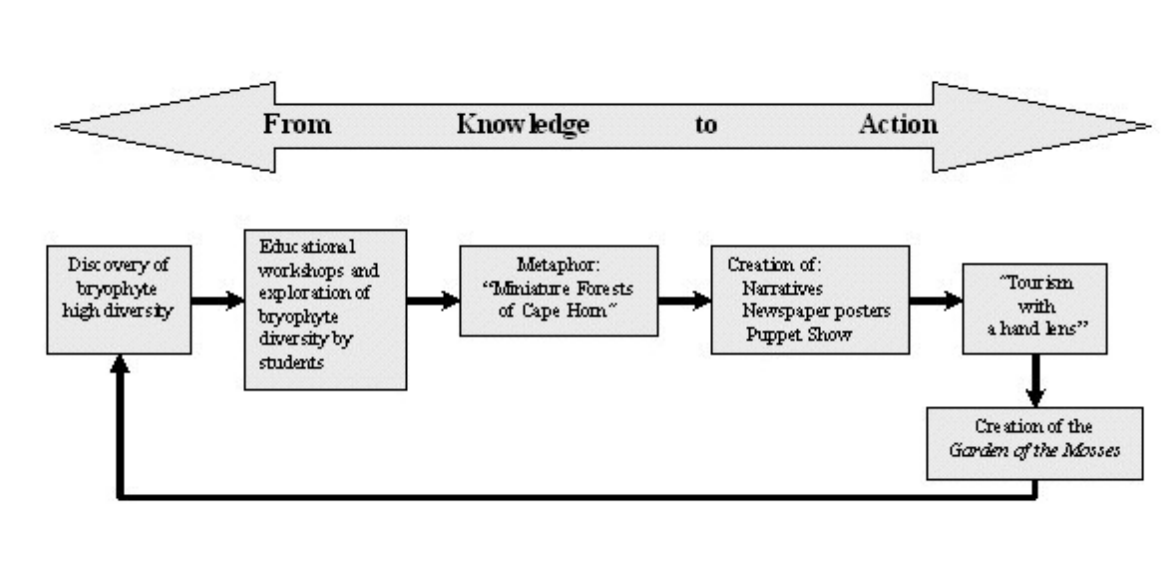
Fig. 4. Scheme showing a cycle of steps from scientific knowledge to conservation actions and back to research again, illustrated by the example of the “Miniature Forests of Cape Horn”